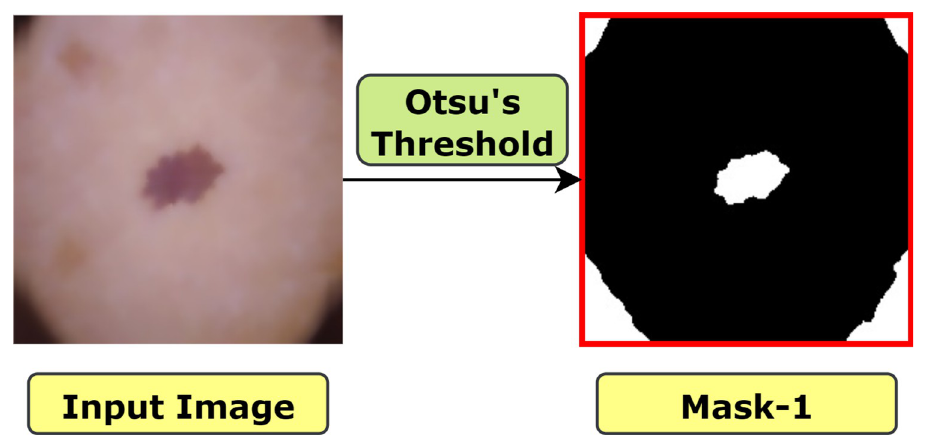
Fig 10. Resultant image after applying Otsu’s